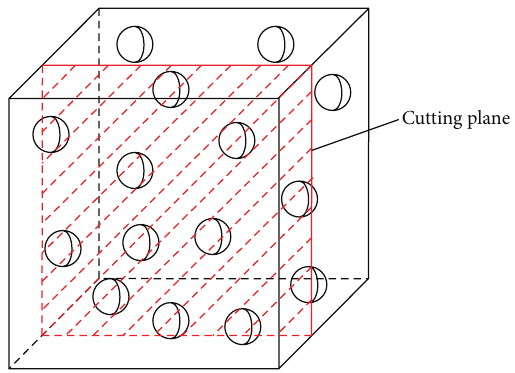
Figure 3: Comparison of effective modulus from analytical models with test.